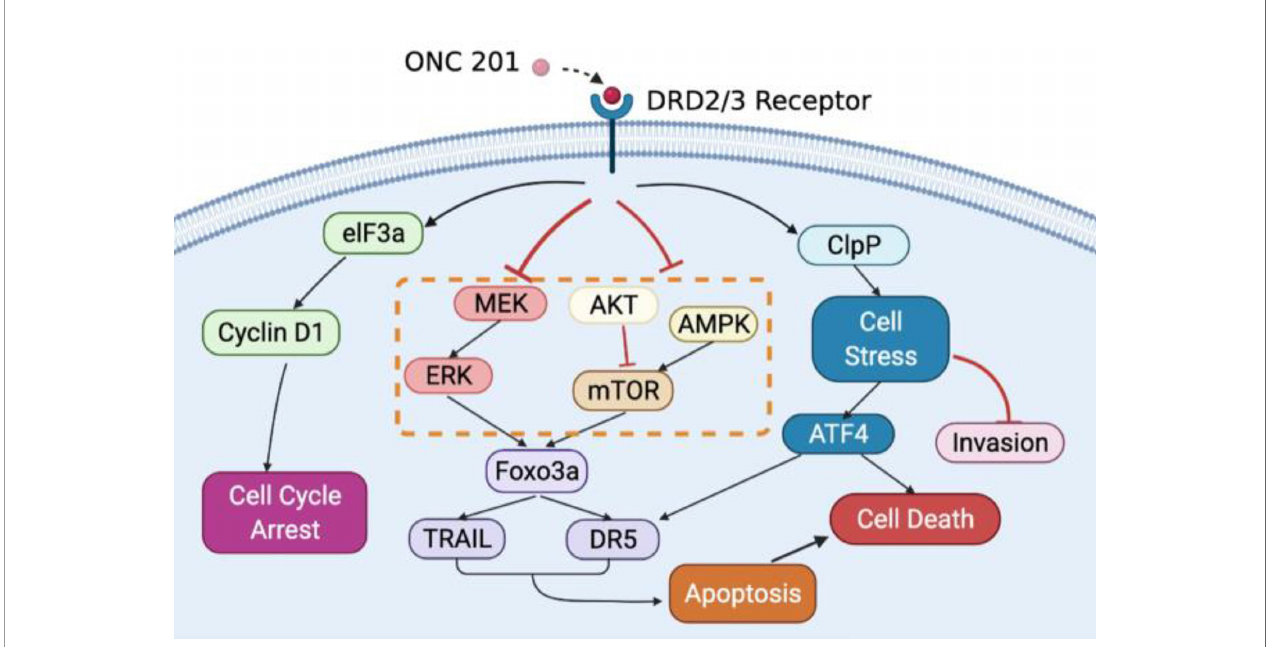
FIGURE 9 | Schematic representation of the potential antitumor mechanisms of ONC201 in OC. ONC201 applies its cell growth-inhibitory impacts through DRD2/3 antagonism and ClpP activation. The connection among DRD2/3 antagonism, activation of ClpP and downstream events elicited by ONC201 including inactivation of AKT/ERK pathways, activation of the integrated stress response, induction of apoptosis, cell cycle arrest, and inhibition of invasion is